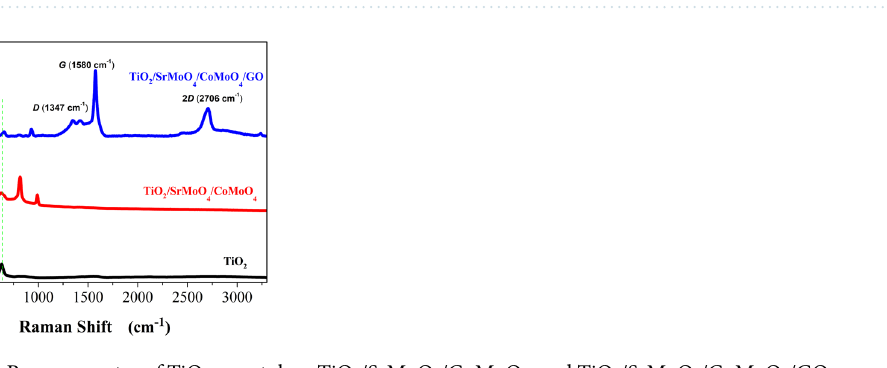
Figure 5. Raman spectra of TiO 2 nanotubes, TiO 2 /SrMoO 4 /CoMoO 4 , and TiO 2 /SrMoO 4 /CoMoO 4